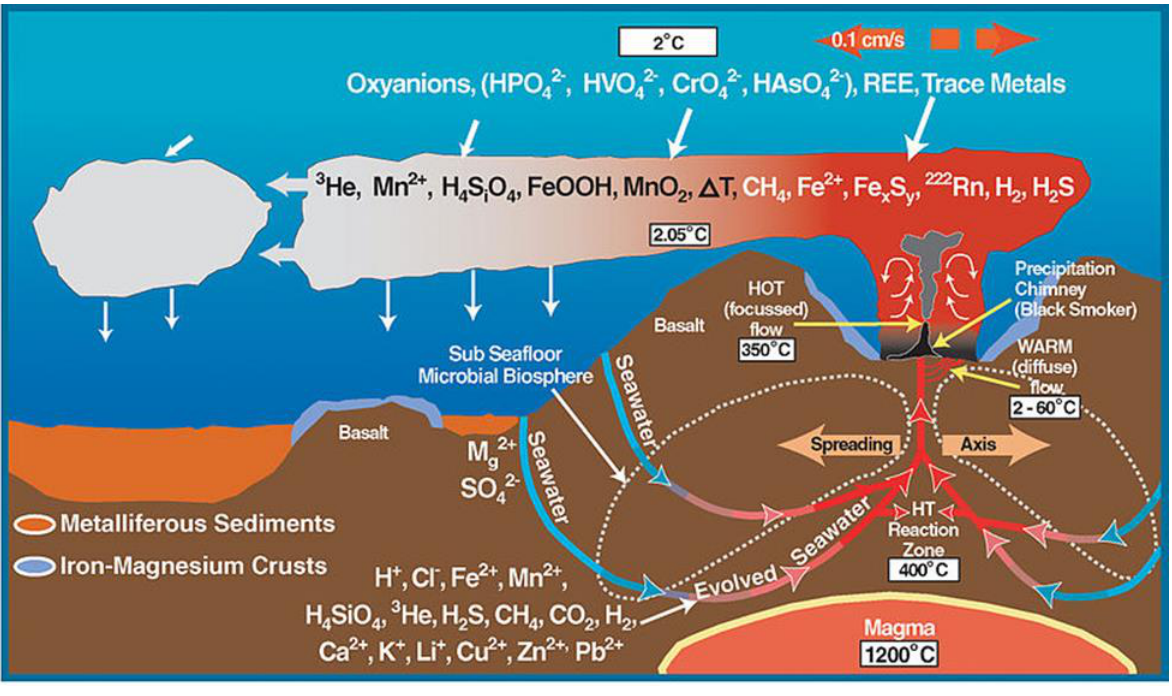
Figure 9. The Dissipative Structure Of A Sea Vent On The Ocean